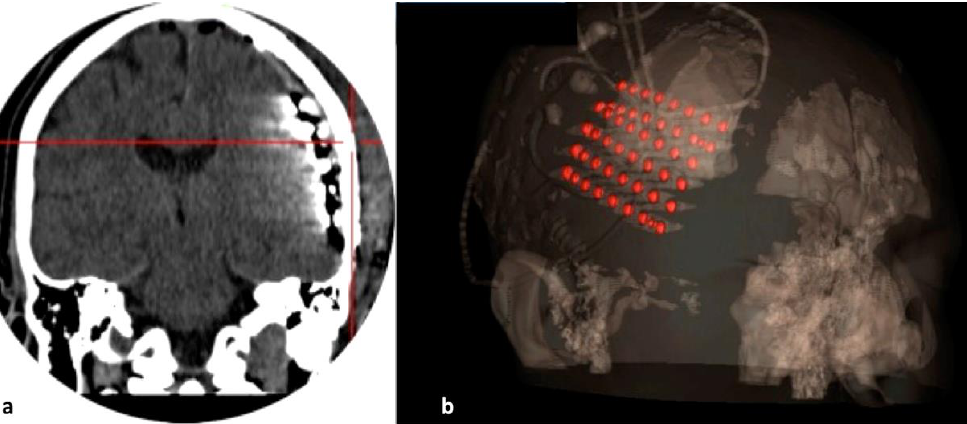
Figure 2. ( a , b ) Postimplantation CT scan (coronal view) and 3D model are used for verifying the location of the implanted electrodes and their contacts.